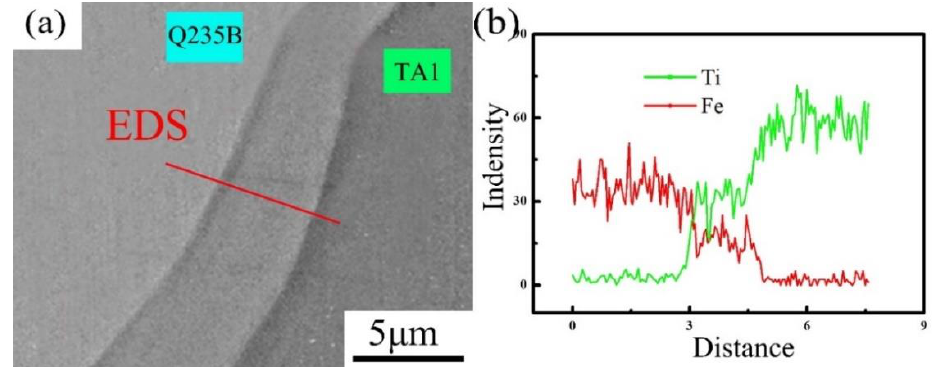
Figure 5. ( a ) SEM microstructure of transition layer, and ( b ) EDS element line distribution for Ti (Green) and Fe (Red) in transition layer of explosive welded TA1/Q235B plate.